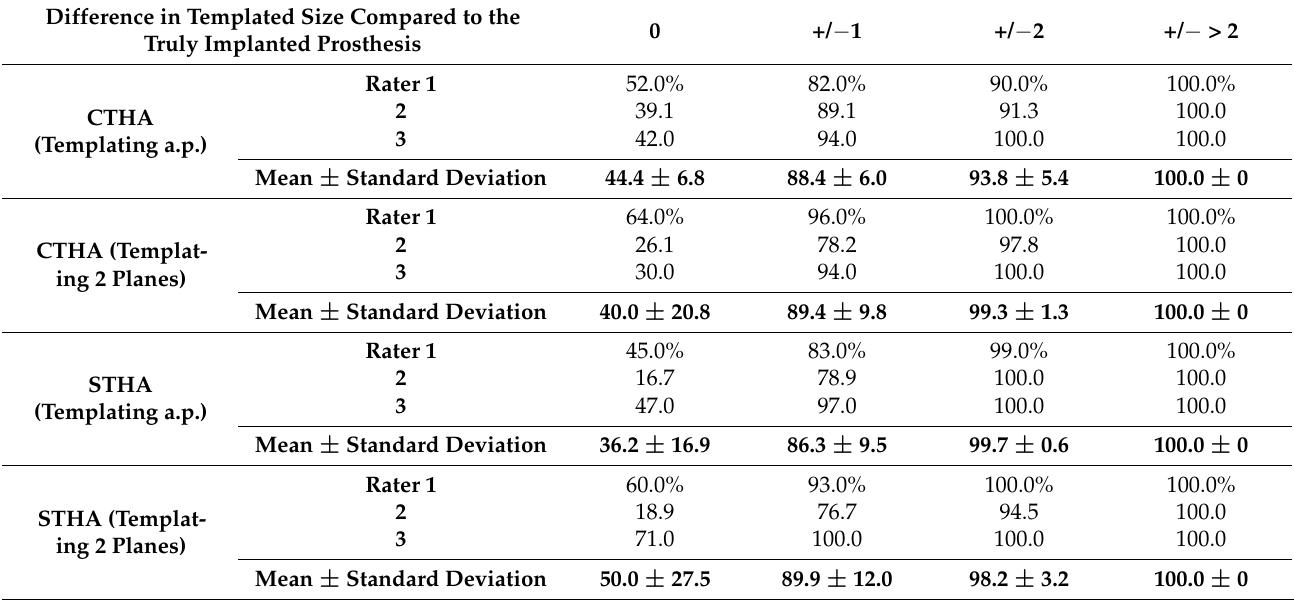
Table 1. Cumulative percentages of the three raters for the conventional (CTHA) and short stem total hip arthroplasty (STHA) groups, using one and two planes, separated in accordance with the variation between the real stem size and the measured size while